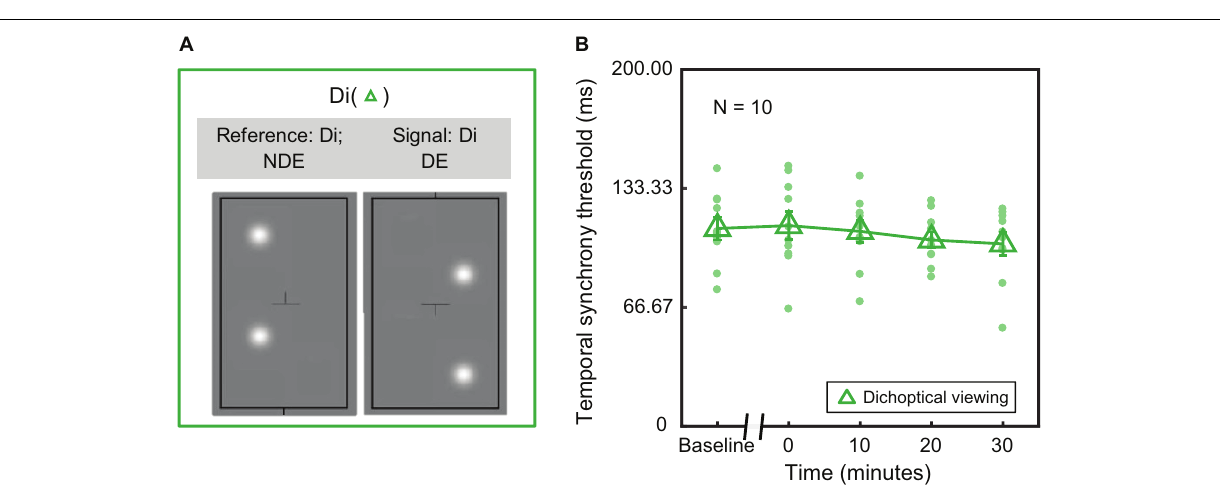
FIGURE 2 | Deprivation effect under dichoptic viewing configuration. (A) An illustration of the Di configuration. Both the signal and reference blobs were presented dichoptically to different eyes. (B) Dichoptic temporal synchrony threshold in the function of various time points before and after deprivation. Each green dot represents the threshold of each subject. Green triangle denotes the average threshold across ten subjects. Error bars represent standard